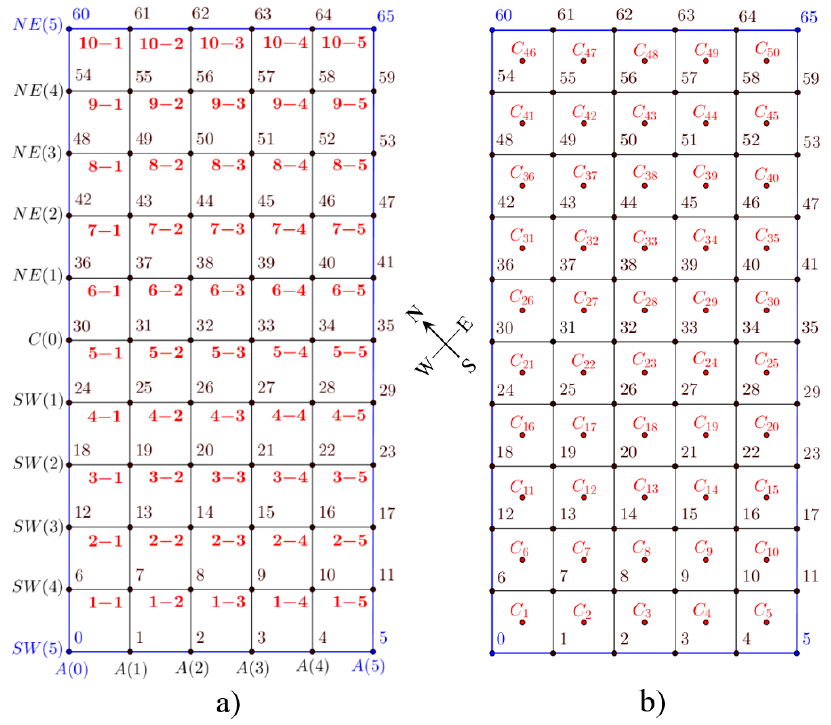
Figure 6. Layout of the sectors and ( a ) and centroids ( b ) in the observation area.